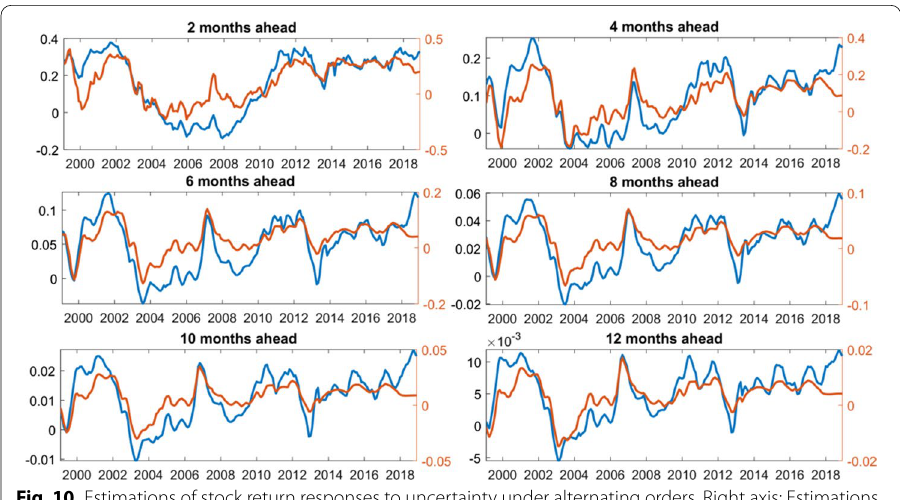
Fig. 10 Estimations of stock return responses to uncertainty under alternating orders. Right axis: Estimations under the order { EPU , R , NEF } . Left axis: Estimations under the order { EPU , NEF , R }